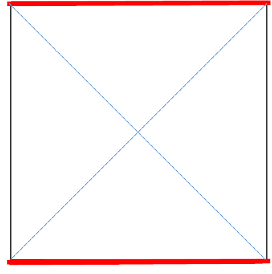
Figure 1 . A rough conformal diagram of a 2-sided AdS-Schwarzschild black hole. The vertical (black) lines are the two disconnected components of the asymptotically-AdS conformal boundary. The heavy horizontal (red) lines are the singularity. In an exact conformal diagram these lines would not meet the AdS boundaries orthogonally (see explicit discussion in [20] and implicit discussion surrounding (cid:12)gure 7 of [21]). The diagonal (blue) lines are the horizons. The associated wormhole is almost traversable in the sense that the past event horizon of one boundary coincides with the future event horizon of the other, so that an in(cid:12)nitesimal perturbation of the geometry (violating the averaged null energy condition as in [22]) could render the wormhole